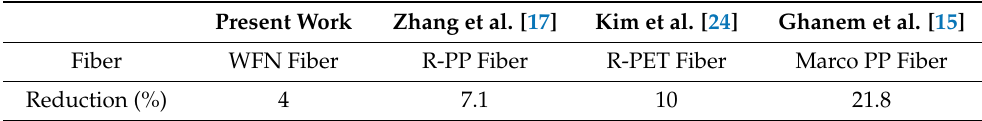
Table 7. Compressive behavior comparison of 1% (by volume) polymeric and recycled polymeric reinforced